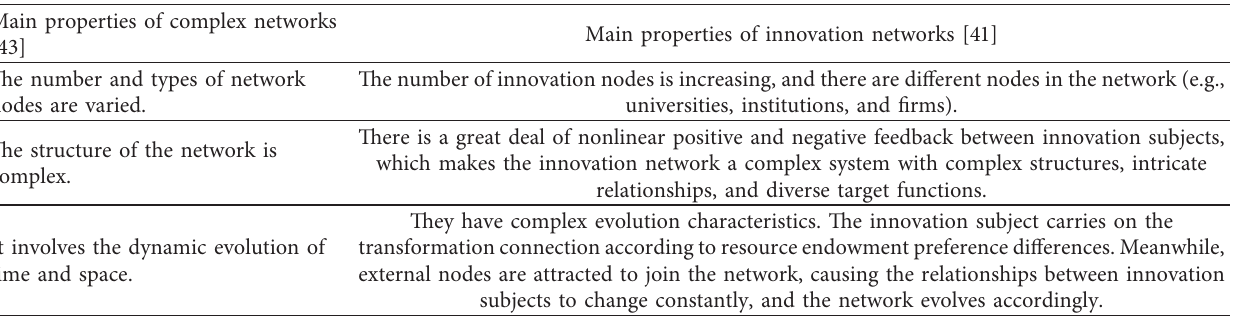
Table 1: Attribute comparison between complex networks and innovation